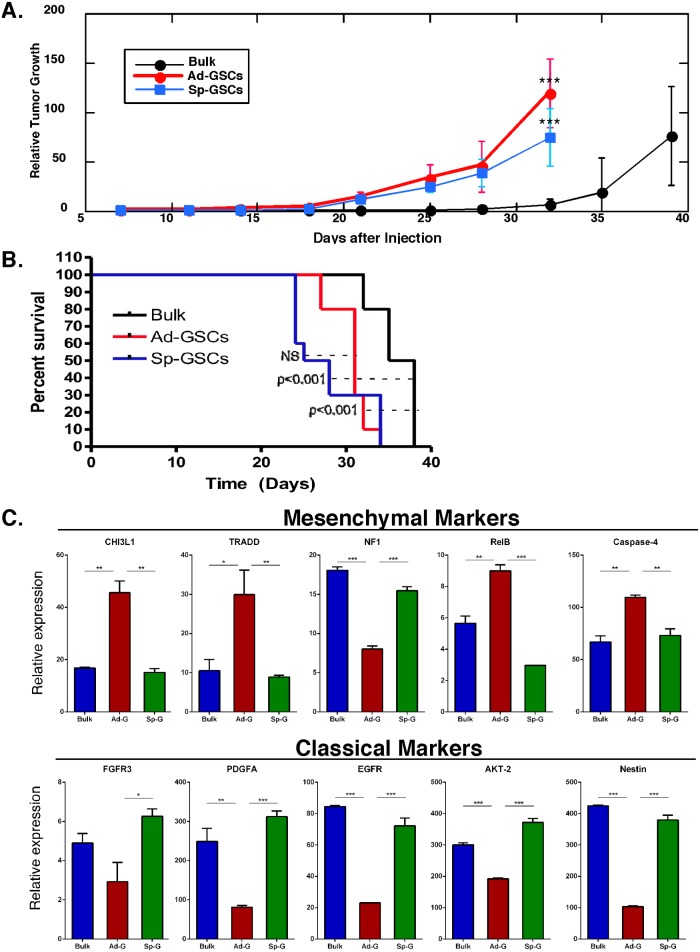
Characterization of GBM6 tumor xenografts.A. CB17 SCID mice were injected with 1x106 luciferase-tagged GBM6 cells grown as bulk tumor cells, Ad-GSCs, or Sp-GSCs, and tumor burden was measured by bioluminescence twice a week (n = 10 per group), and (B) Kaplan-Meier analysis of survival data (n = 8) was performed. C. RNA isolated from intracranial tumors was subjected to qPCR as indicated and normalized to actin expression (n = 3). Error bars, S.D. * p < 0.05, ** p < 0.01, *** p < 0.001.